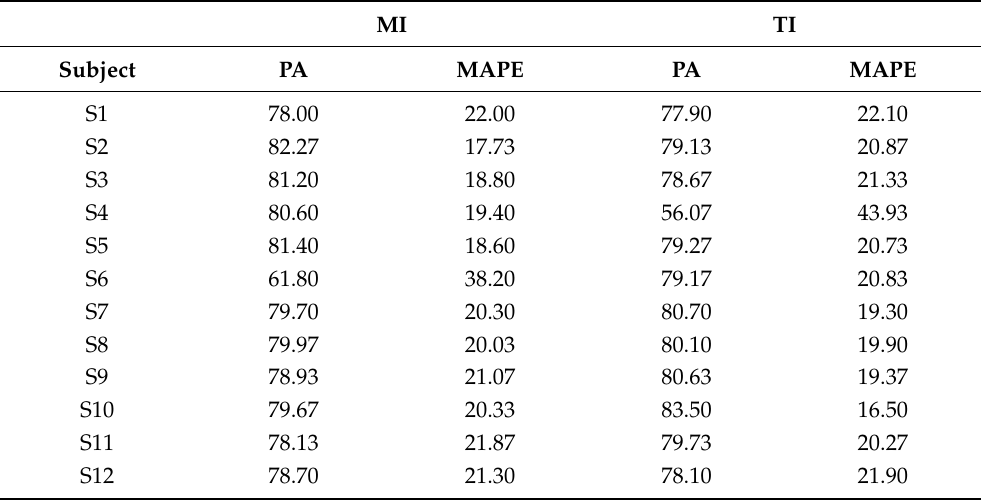
Table 1. Mean absolute percentage error (MAPE) and prediction accuracy (PA) of the artificial neural network (ANN)